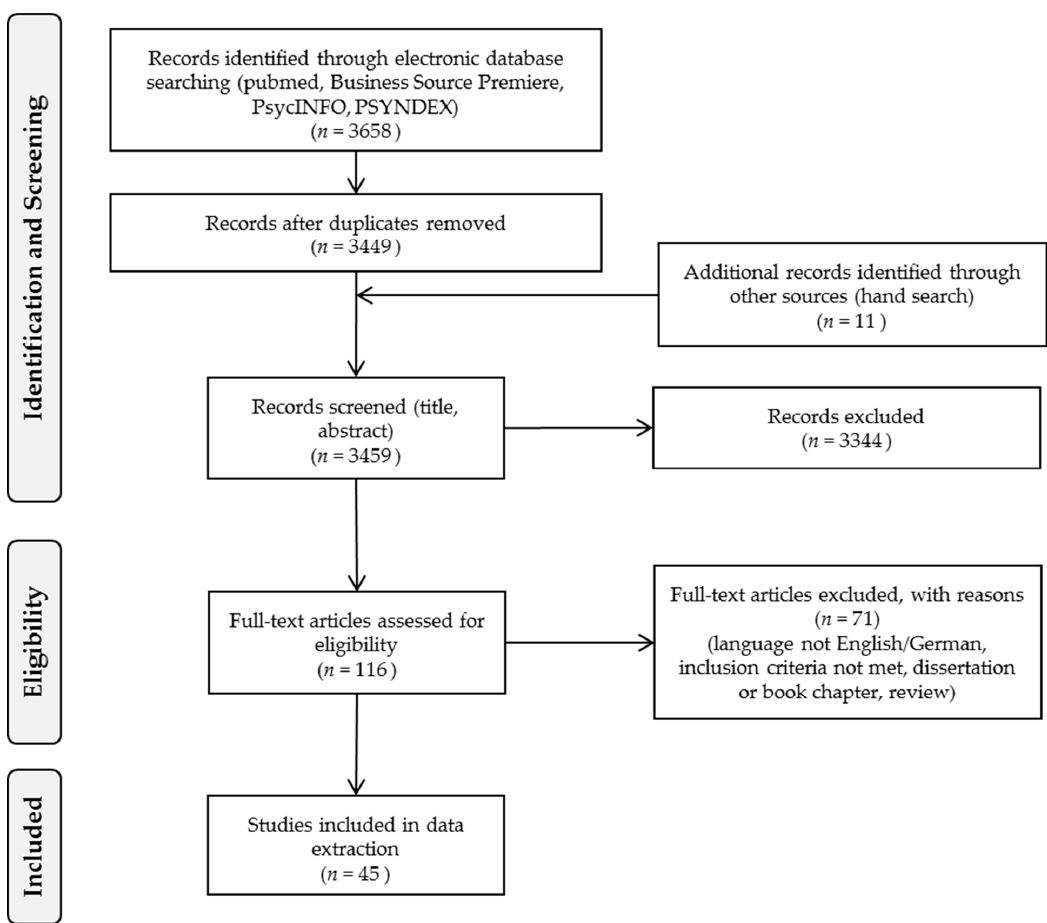
Figure 1. PRISMA Flow Diagram [56] on database search and study selection.